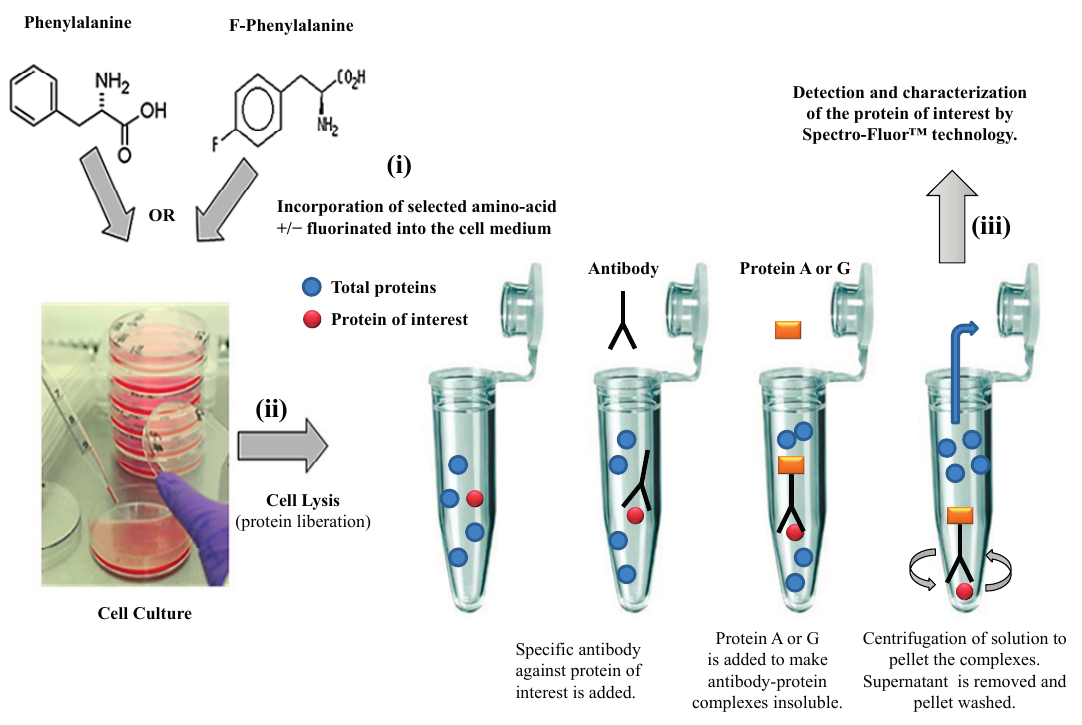
Figure 2. Flow chart of the experimental methodology. The three-step process is resumed by: ( i ) Ex-vivo protein labeling by incorporation of either 4-fluoro- L -phenylalanine. L -phenylalanine is used as a control; ( ii ) immune-precipitation by using only one antibody against the antigen/epitope of the protein of interest; ( iii ) detection and characterization of the protein of interest by Spectro-Fluor™